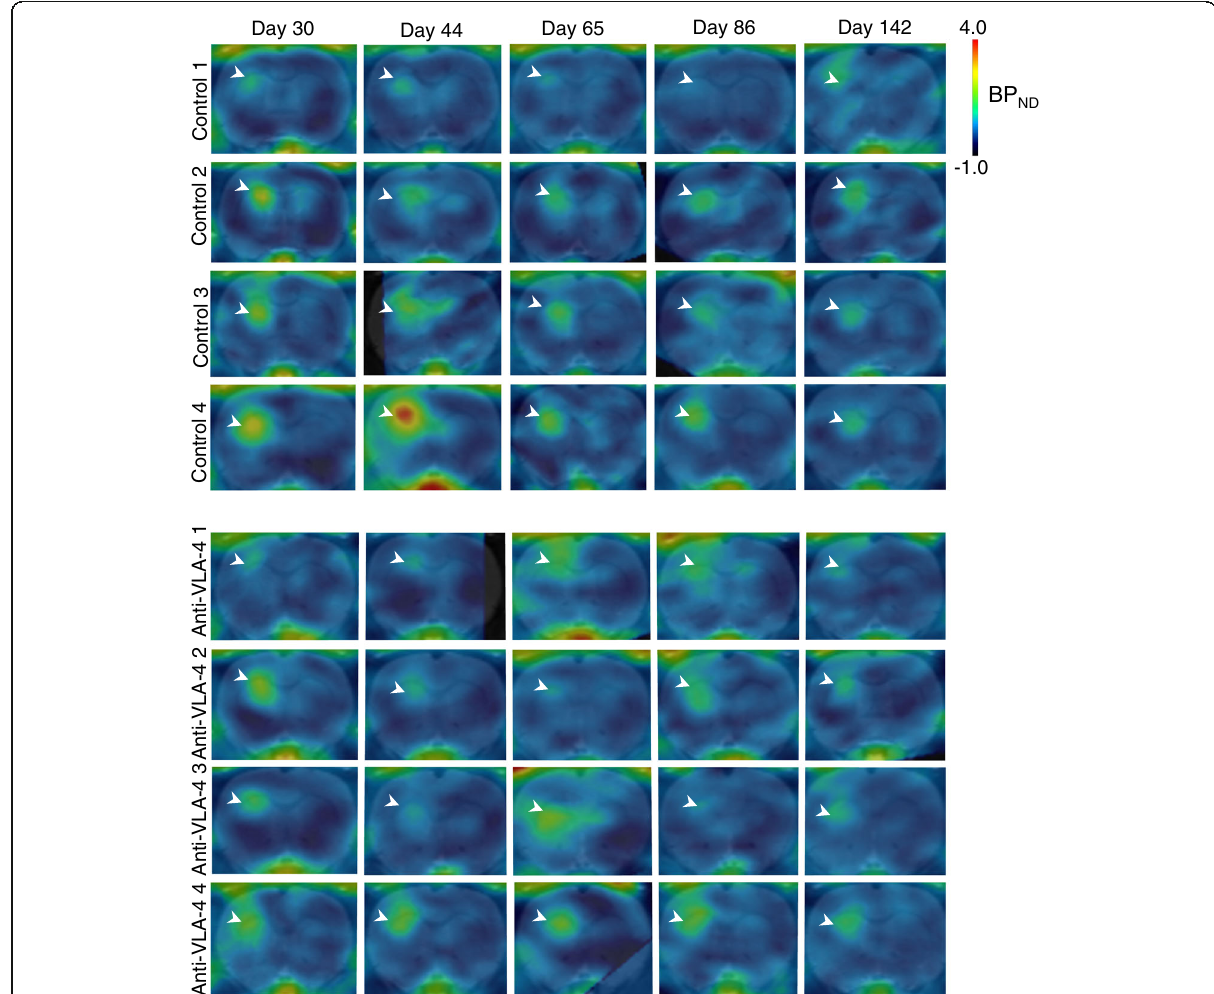
Fig. 2 Time course of f DTH-EAE in PET imaging of rat brains. Representative coronal images of the BP ND maps modelled with simplified reference tissue modelling and overlaid on a Schiffer MRI template. The control animals ( n =4) are shown in the top panels. The anti-VLA-4 mAb treated animals ( n =4) are shown on day 30 (when treatment was started), day 44, day 65 (at which time the treatment had been stopped for 4days), day 86 and day 142. White arrow-heads point at the lesion. BCG Bacille Calmette-Guérin, BP ND non-displaceable binding potential, fDTH focal delayed-type hypersensitivity, EAE experimental autoimmune encephalomyelitis, mAb monoclonal antibody, MRI magnetic resonance imaging, PET positron emission